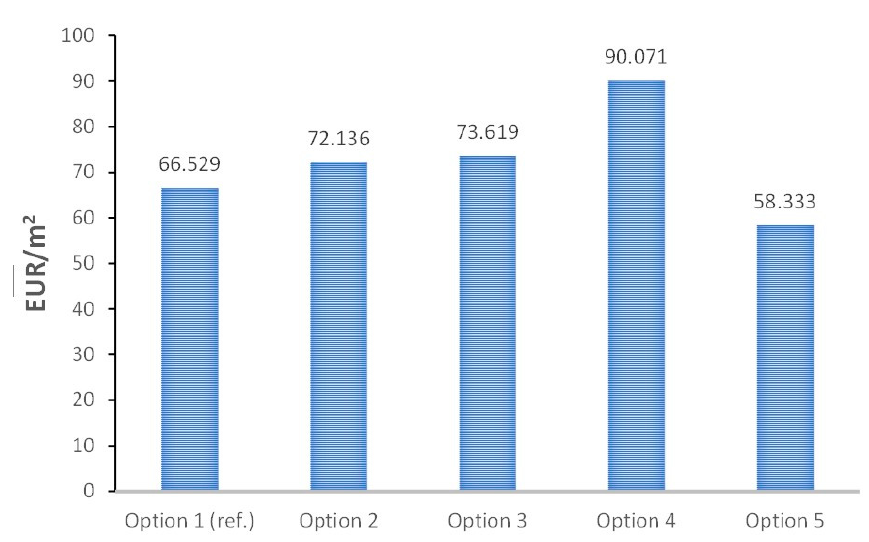
Figure 3. LCC/GFA building costs (EUR/m 2 ).